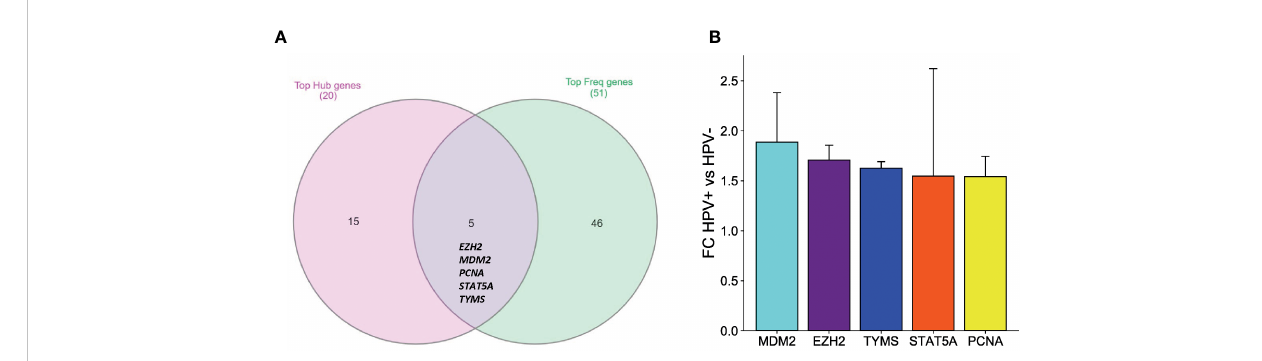
FIGURE 5 An integrative analysis of the key DEGs in HPV + compared to HPV - HNSCC patients. (A) Venn diagram showing the overlapping between the top hub genes generated by PPI analysis and the top frequent genes resulting from the GSEA analysis. (B) Bar graph comparing the gene expression fold changes identi fi ed by the integrated network analysis. Five upregulated genes in HPV + compared to HPV - HNSCC patients. The standard deviation error bar for each is presented showing the variability of each gene expression amongst the three